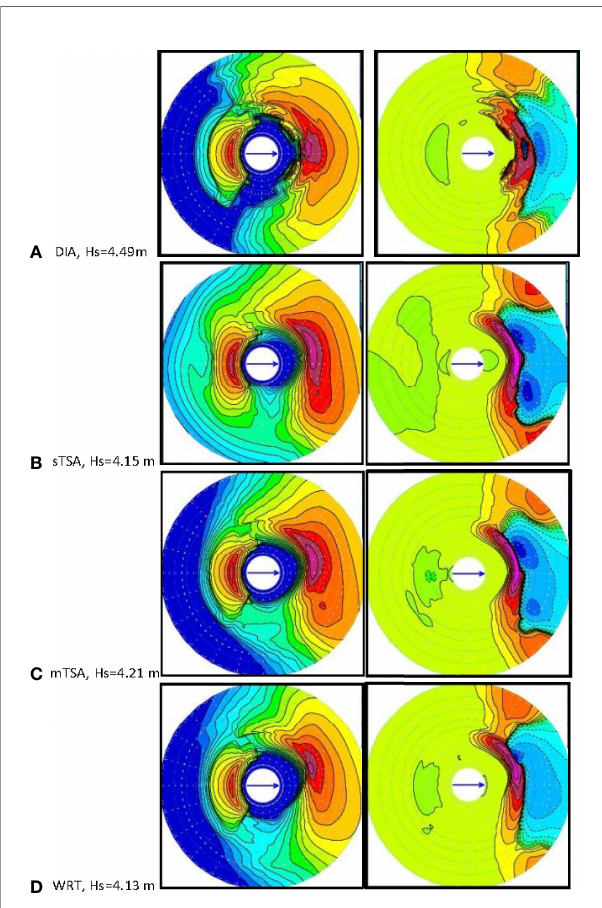
DC FIGURE 3 | Evolving spectra starting with initial conditions as Figure 1 , after time of 10 hours evolution, with 20m/s wind opposing the swell, from west to east and ST4 source terms: (A) DIA, (B) single-TSA, or sTSA, (C) multiple TSA, or mTSA, (D) WRT, showing 2-D energy in the left column and 2-d S nl in the right. Hs (m) as indicated. Same color bars and scales as Figure 1